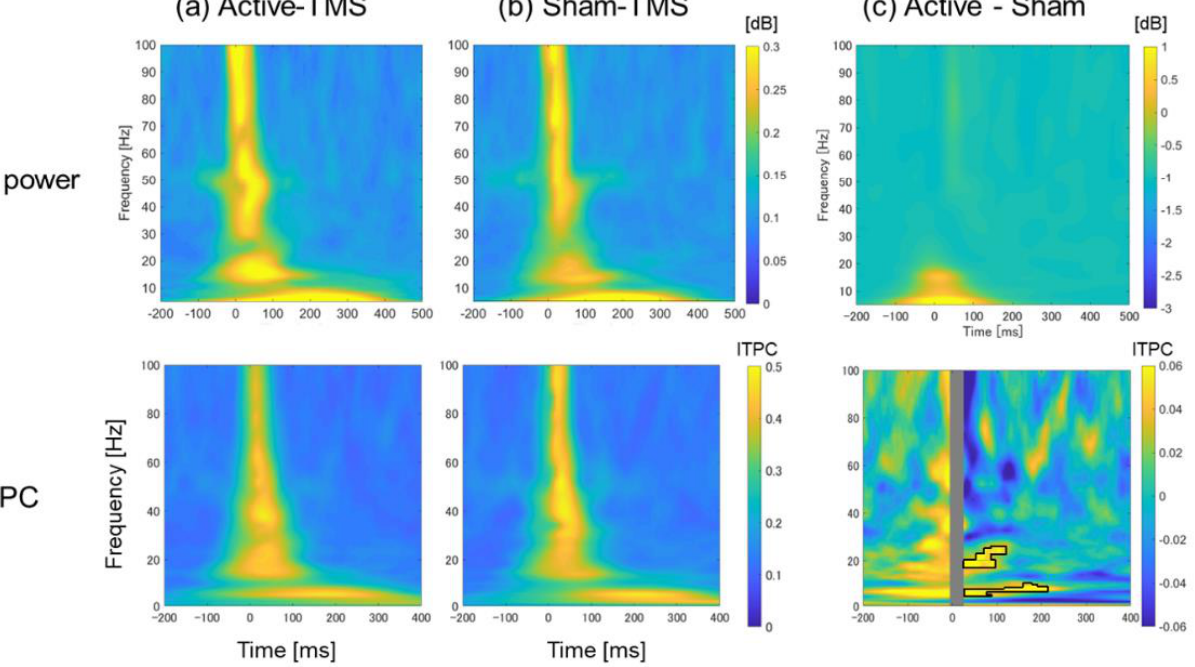
Figure 2. Time–frequency analyses (total power and ITPC) in the active and sham conditions. Upper panel: Total power analysis in the DLPFC stimulation electrode sites for each condition averaged over all participants. The panel ( a ) represents the total power elicited by active stimulation, panel ( b ) represents the total power elicited by sham stimulation, and panel ( c ) shows the difference in total power between the active and sham conditions (i.e., ( a ) minus ( b )). Lower panel: ITPC analysis in the DLPFC stimulation electrode sites for each condition averaged over all participants. The panel ( a ) shows the ITPC map elicited by active stimulation, panel ( b ) shows the ITPC map elicited by sham stimulation, and panel ( c ) shows the difference in ITPC between the active and sham conditions (i.e., ( a ) minus ( b )). The inner black line in the graph in panel ( c ) shows the area of ITPC where significant group differences were found between the active and sham conditions.